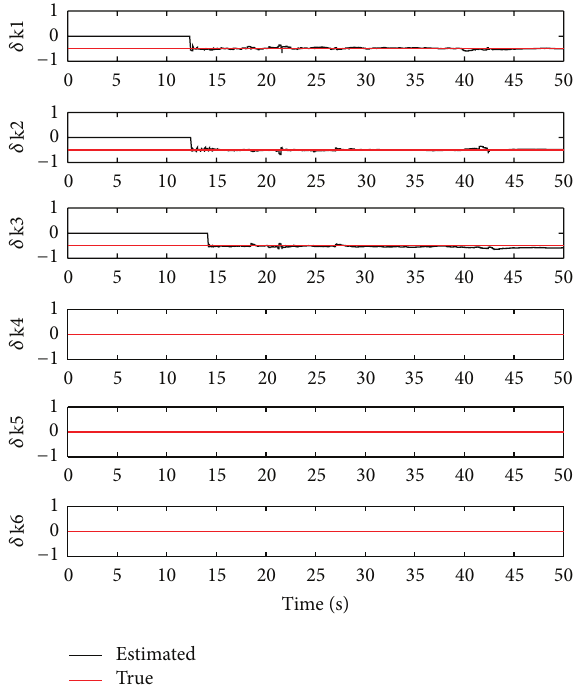
Figure 5: Damage stiffness estimation using the OTSKE with 𝑄 𝑑 𝑘 = diag {1000𝐼 3 ,0.001𝐼 3 } .